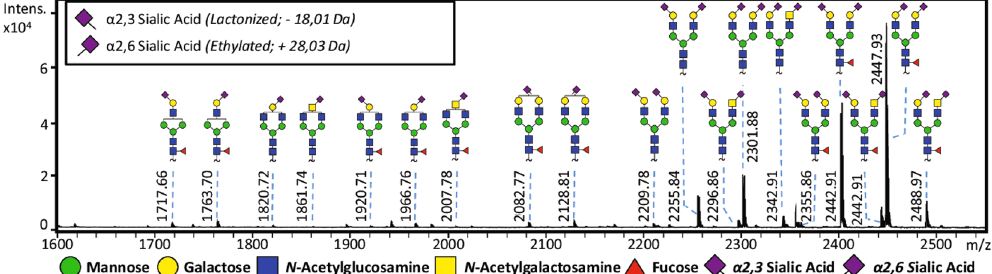
Figure 2. MALDI-TOF-MS spectrum of PNGase F released PSA N -glycans treated with ethyl esterification. A total of 37 different glycans were identified (not all data shown, a complete overview can be found in Table S-3, Supplementary